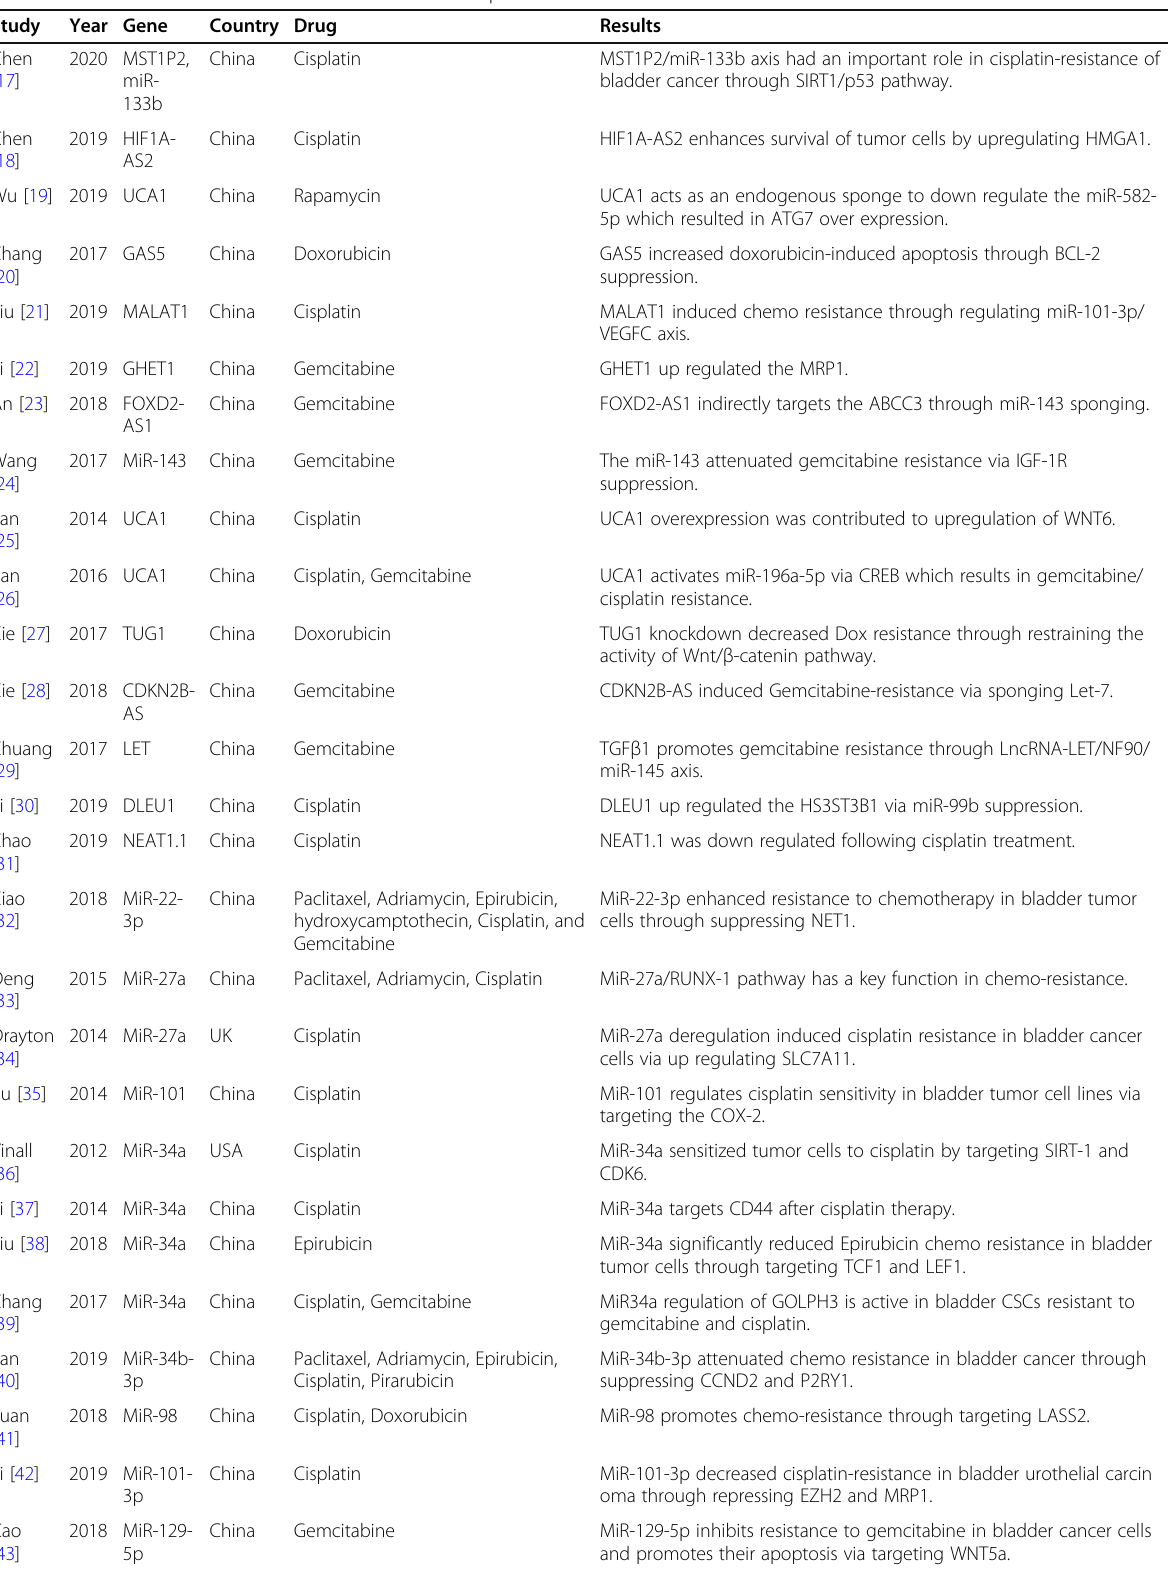
Table 1 all of the ncRNAs associated with chemotherapeutic resistance in BCa Study